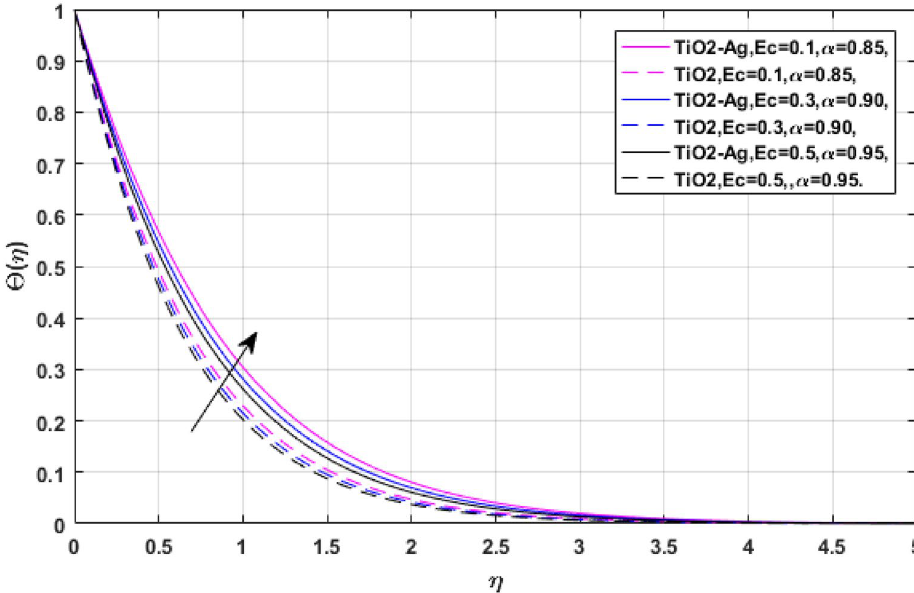
Figure 16. Ec versus temperature field when (cid:31) = M = E = 0.1, φ 1 = φ 2 = 0.02, Pr = 21.